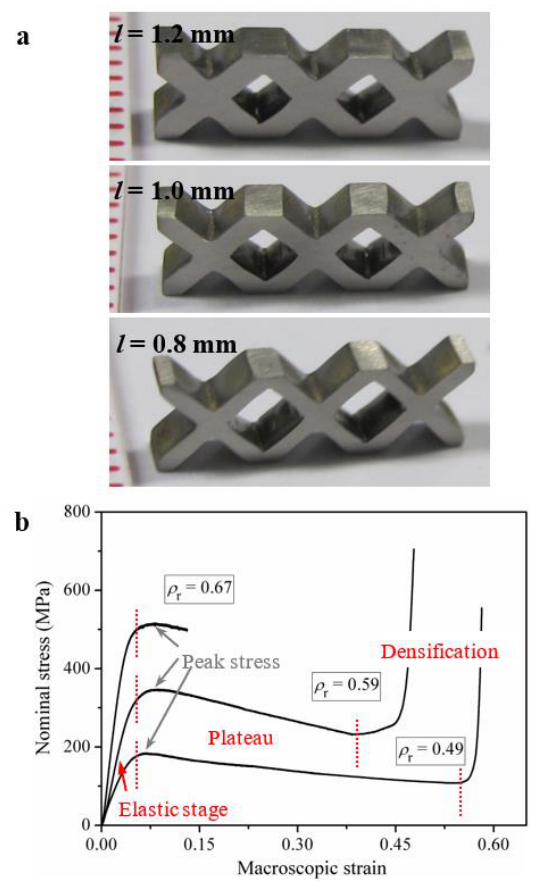
Figure 4. ( a ) Three cellular MGs with macroscopic cellular structures with varying strut thicknesses. ( b ) The nominal stress – strain curves of the three cellular MGs with macroscopic cellular structures. Adapted from [12] with copyright permission from AIP Publishing, 2014.